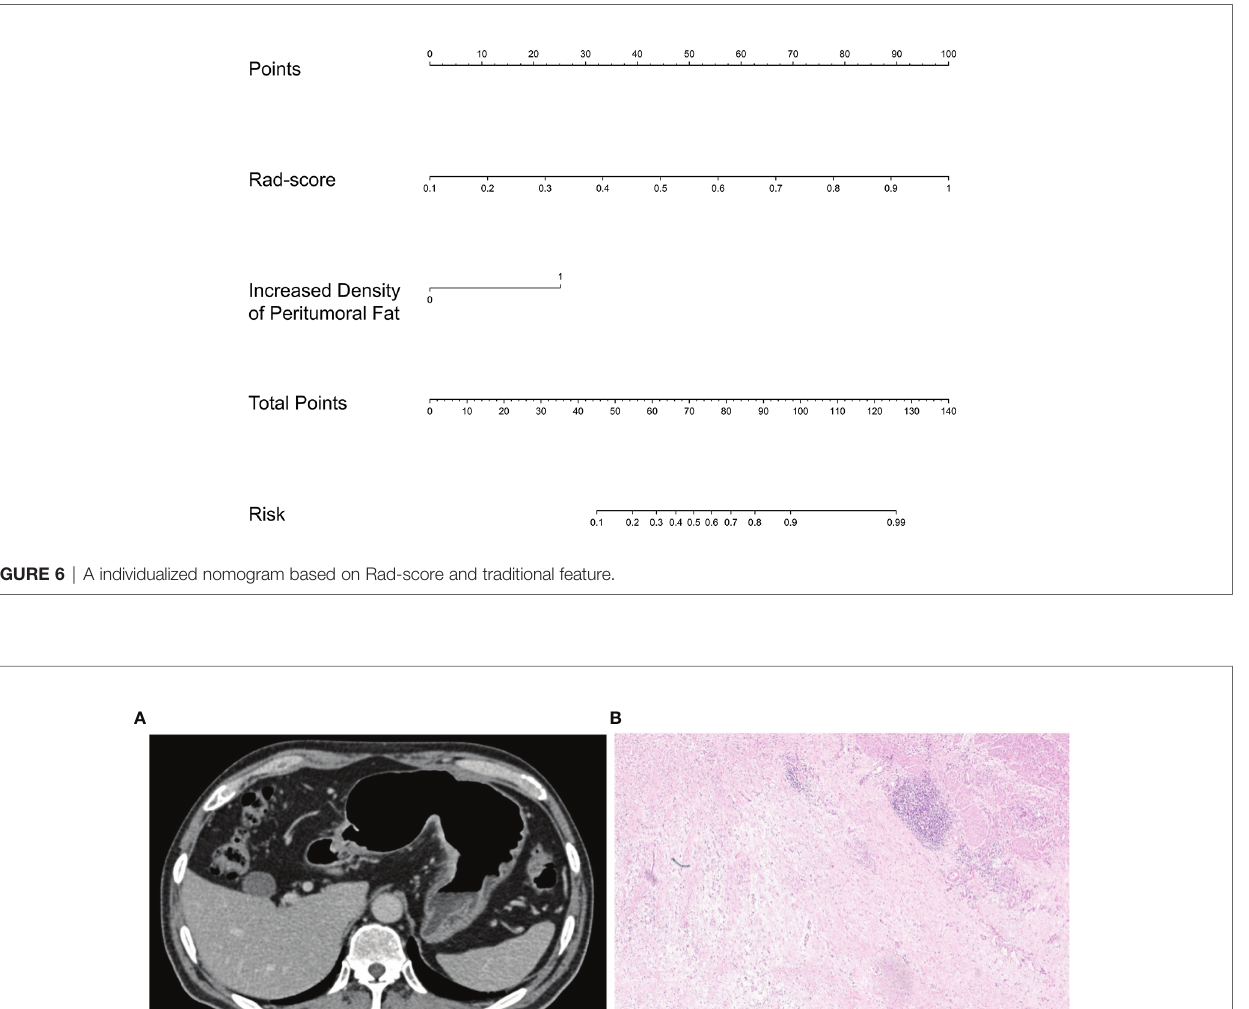
FIGURE 7 | A 65-year-old male patient with increased perigastric fat density and Rad-score of 0.277,the nomogram showed a low risk of serosal invasion (risk = 0.11). (A) A mixed image in the portal venous phase showed the thickening of the lateral wall of the gastric lesser curvature with transmural enhancement, rough serosal surface, and increased perigastric fat density, with a positive clinical model diagnosis of serosal invasion. (B) Pathological images (HE, 100×) showed a large number of lymphocytes aggregated on the serosal surface with fi brous hyperplasia, and no cancer cell in fi ltration was observed, which was consistent with the judgement of nomogram.